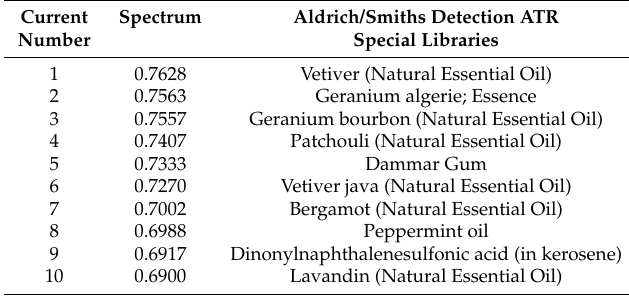
Table 3. 10 volatile compounds identified in the chemical structure of hybrid resin of type 2.